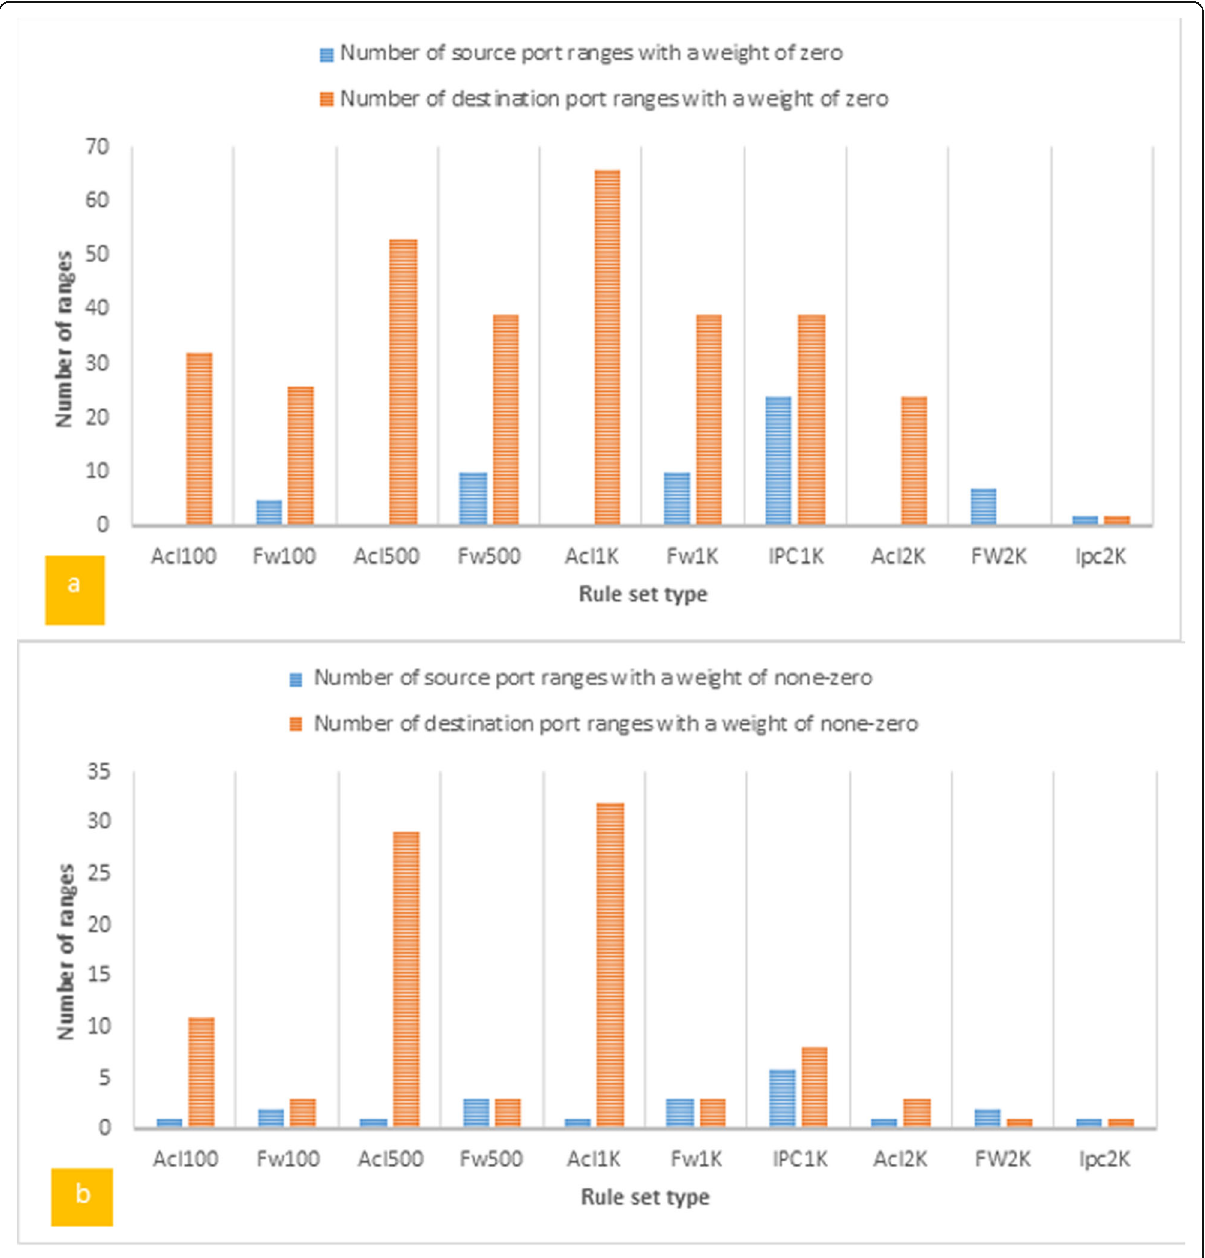
Fig. 8 The number of ranges in the source and destination ports of ten different rule sets a ranges with a weight of zero; b ranges with non-zero